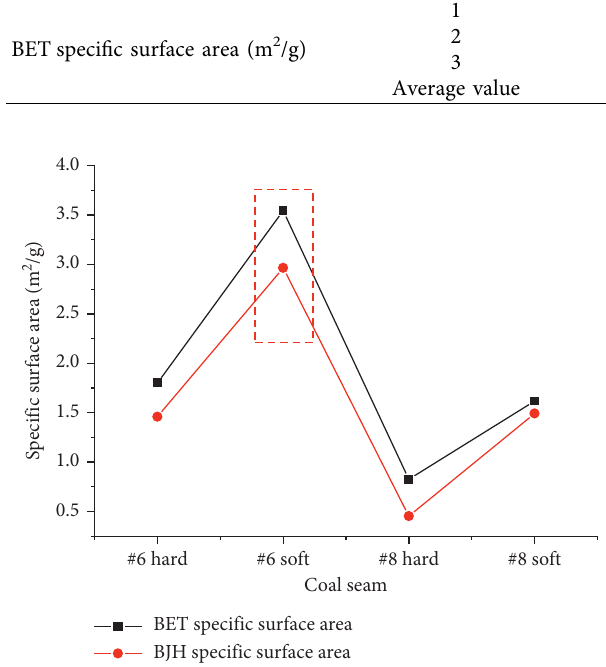
Table 2: BJH specific surface areas of the different coal seams. Pore structure parameters